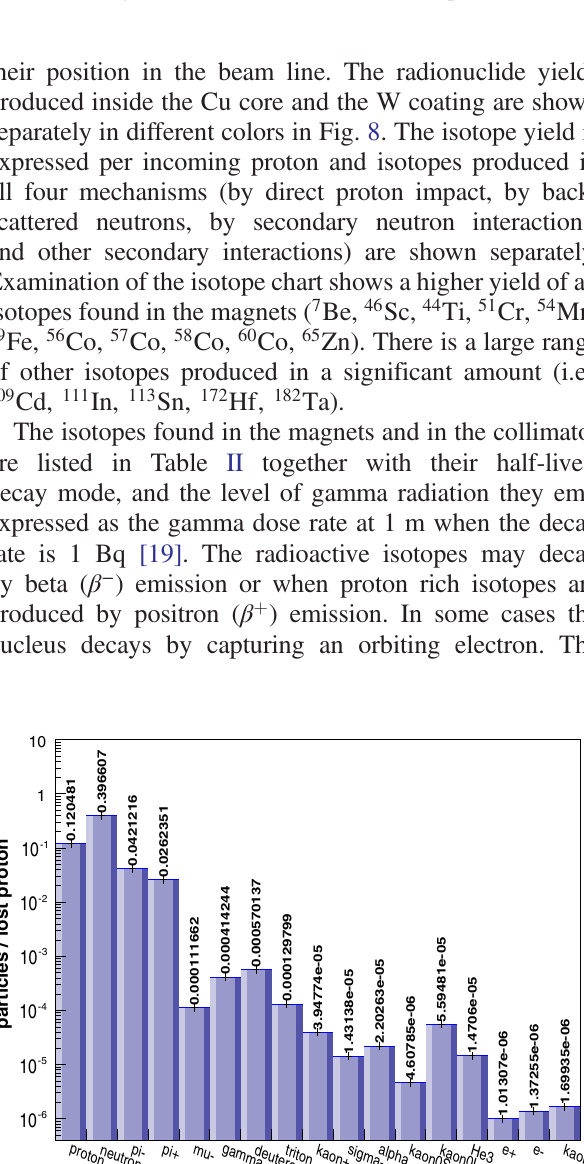
4. The magnets and collimator design for the HEBT-S3 beam line. For magnets, the Cu parts are shown in red while the Fe parts are shown in green. For the collimator, the Cu parts are shown in yellow while the W parts are shown in